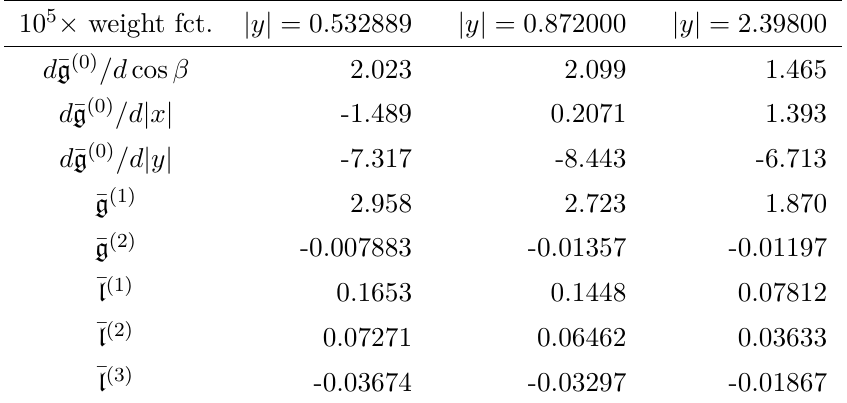
Table 1 . The weight functions (multiplied by 10 5 ) for | x | = 0 . 4 , cos β = 0 . 6 and three different values of | y | . The muon mass is set to unity throughout this